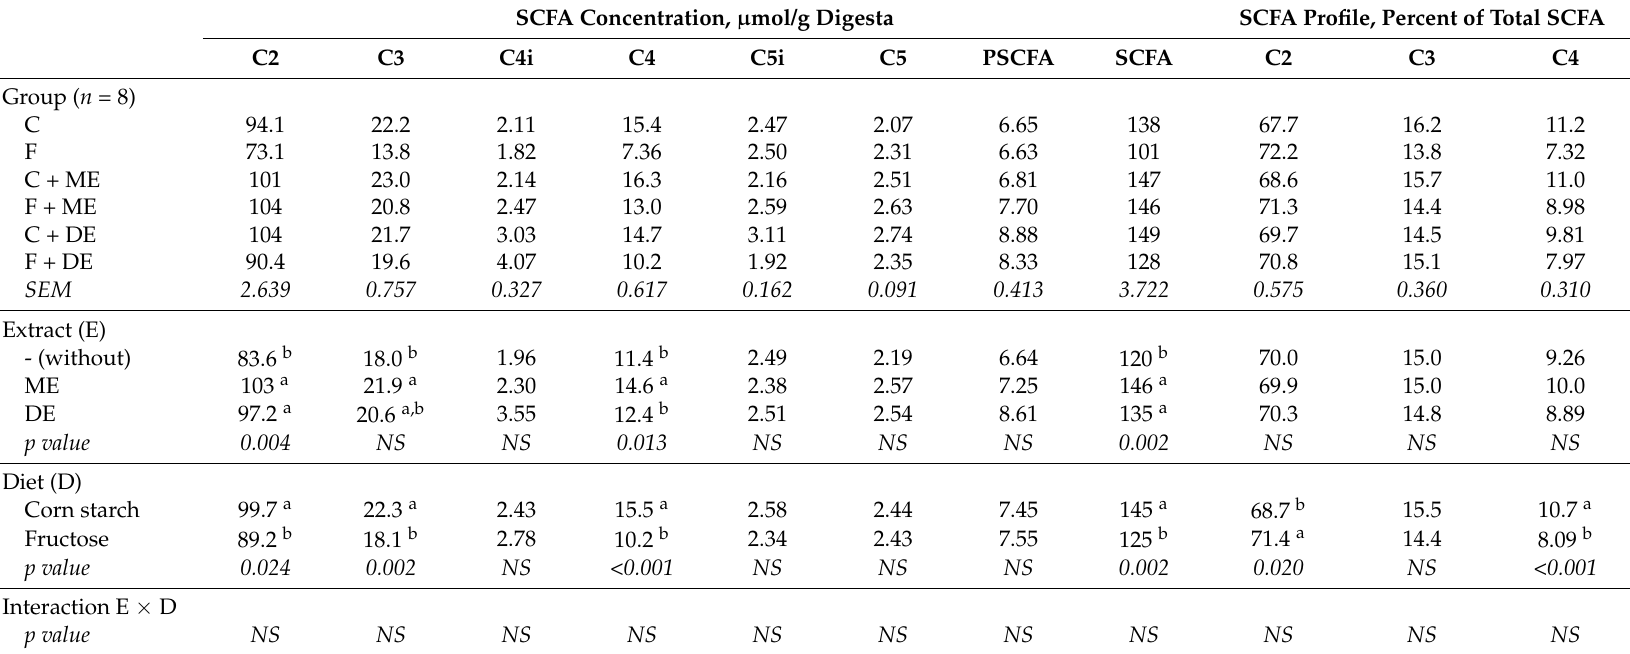
Table 5. Short-chain fatty acid (SCFA) concentration and profile in the cecal digesta of rats fed experimental diets *. SCFA Concentration, µ mol/g